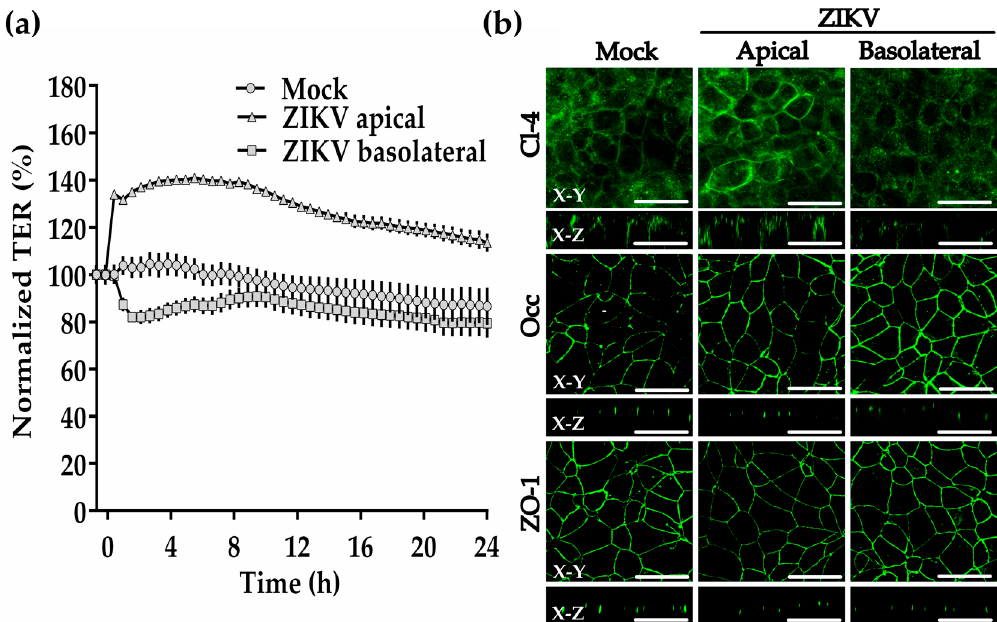
Figure 5. ZIKV added to the basolateral surface of BeWo cells transiently diminishes the transepithelial electrical resistance and claudin-4 expression. Confluent monolayers of BeWo cells that had achieved a stable value of TER were incubated with ZIKV (MOI = 1) added to the apical or basolateral surface. ( a ) TER was continuously measured in the cellZscope system in three inserts per condition. Results are shown with the corresponding standard deviation. ( b ) Immunofluorescence for claudin-4, occludin and ZO-1 in BeWo monolayers done after 1.5 h of incubation with ZIKV. Bar, 50 µm. X-Y, en face view; X-Z, lateral view.